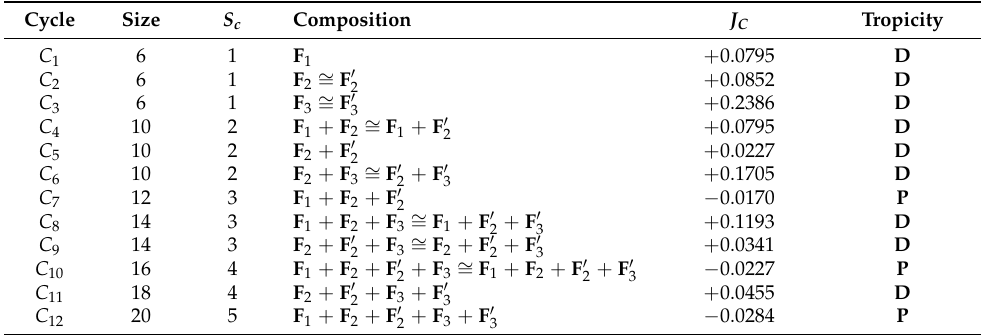
Table 5. Cycle contributions to HL current in the non-Kekulean benzenoid I . D and P stand for diatropic and paratropic contributions,